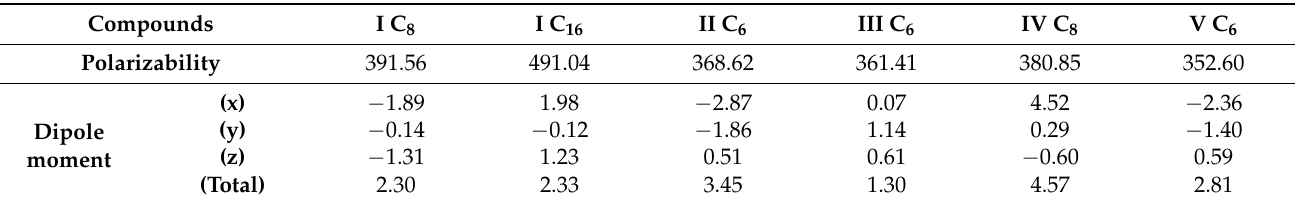
Table 5. Polarizability α (a 03 ) and dipole moments (debye) of compounds I C 8 , I C 16 , II C 6 , III C 6 , IV C 8 , and V C 6